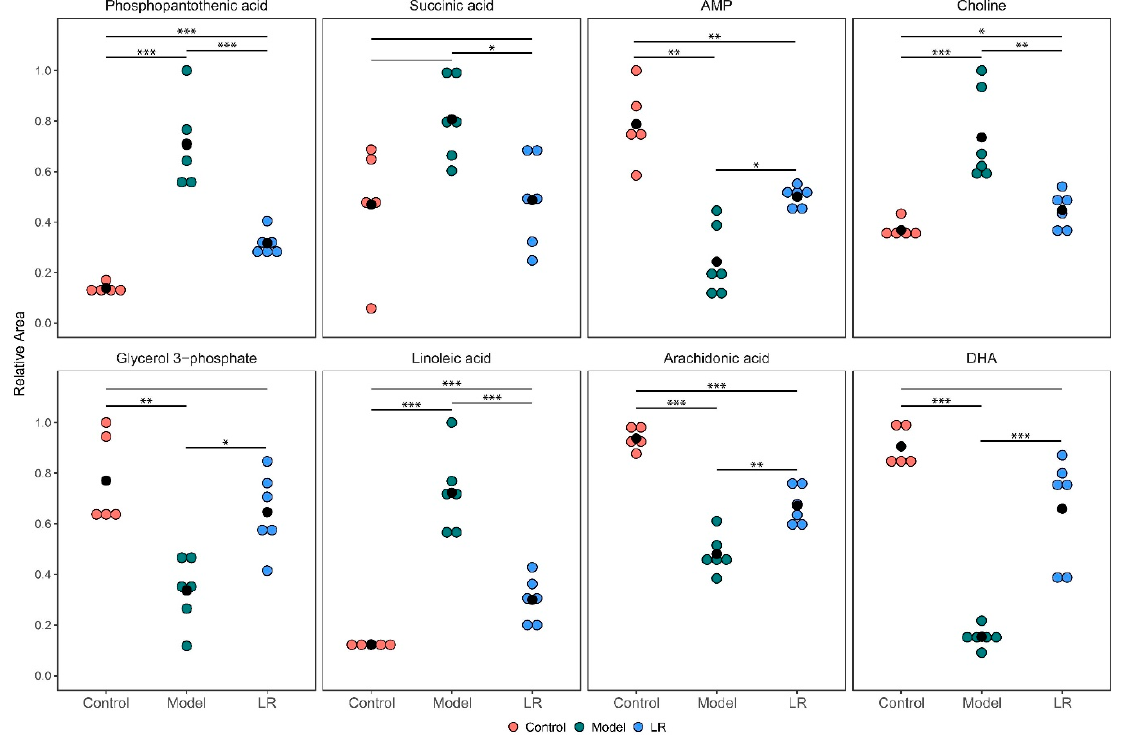
Figure 4. Relative levels of the selected eight metabolites in the liver of mice from the control, model, and LR groups. The hypothesis test for the difference between two means was conducted through t -test. *: p < 0.05; **: p < 0.01; ***: p < 0.001.